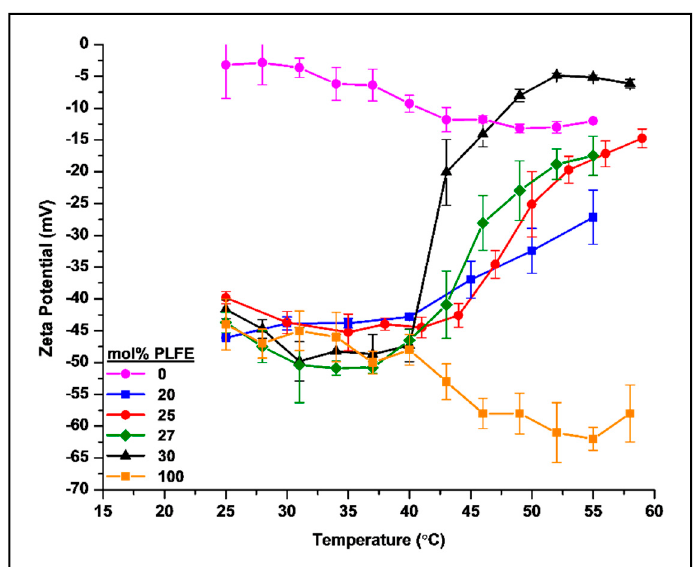
Figure 2. Temperature dependence of ZP measured on PLFE/DPPC liposomes at various PLFE mole fractions over the temperature range 25–58 ° C. Error bars are the standard deviations from three independent measurements. Particle size (146 ± 2.5 nm) and polydispersity (0.09 ± 0.01) of PLFE/DPPC(3:7) archaeosomes remained virtually unchanged in the temperature range examined. Liposomes were dispersed in 50 mM Tris buffer (pH 7.2) containing 10 mM EDTA and 0.02% NaN 3 .